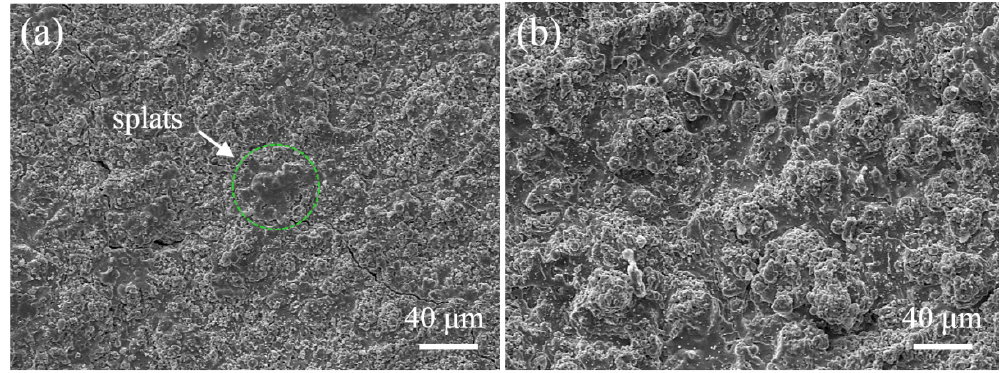
Figure 7. Typical surface morphologies of the coating after failure: ( a ) 15–25 μ m; and ( b ) 45–60 μ m.